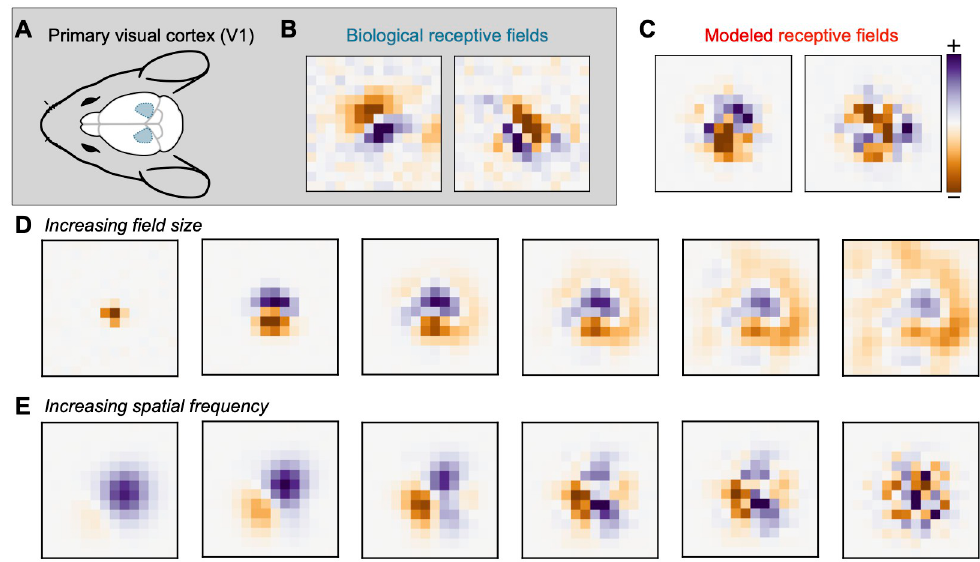
Fig 4. Random receptive field model of Primary Visual Cortex (V1). (A) Diagram of the mouse brain with V1 shown in blue. (B) Receptive fields of two mouse V1 neurons calculated from their response to white noise stimuli. The fields are localized to a region in a visual field and show “on” and “off” regions. (C) Random samples from the model Eq (9) distribution. (D) Increasing the receptive field size parameter in our model leads to larger fields. (E) Increasing the model spatial frequency parameter leads to more variable